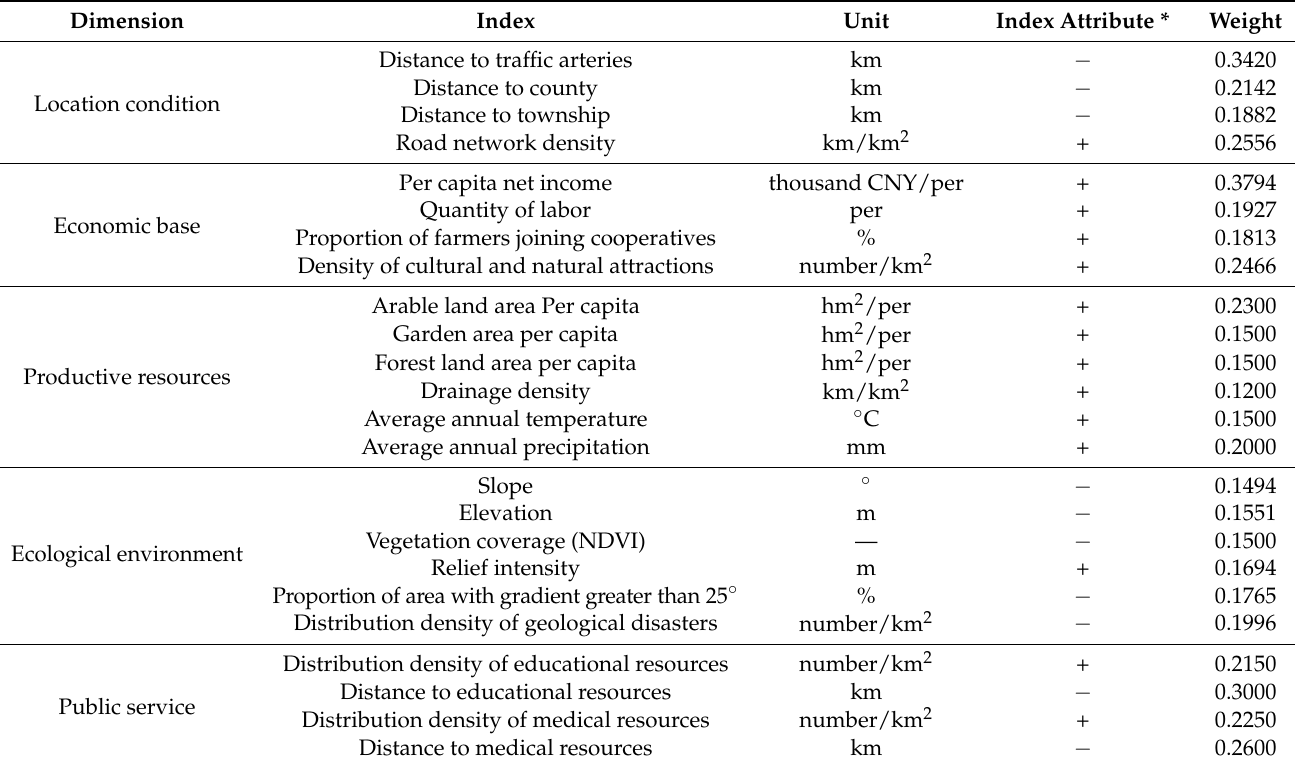
Table 2. Evaluation index system of rural regional system in Nujiang